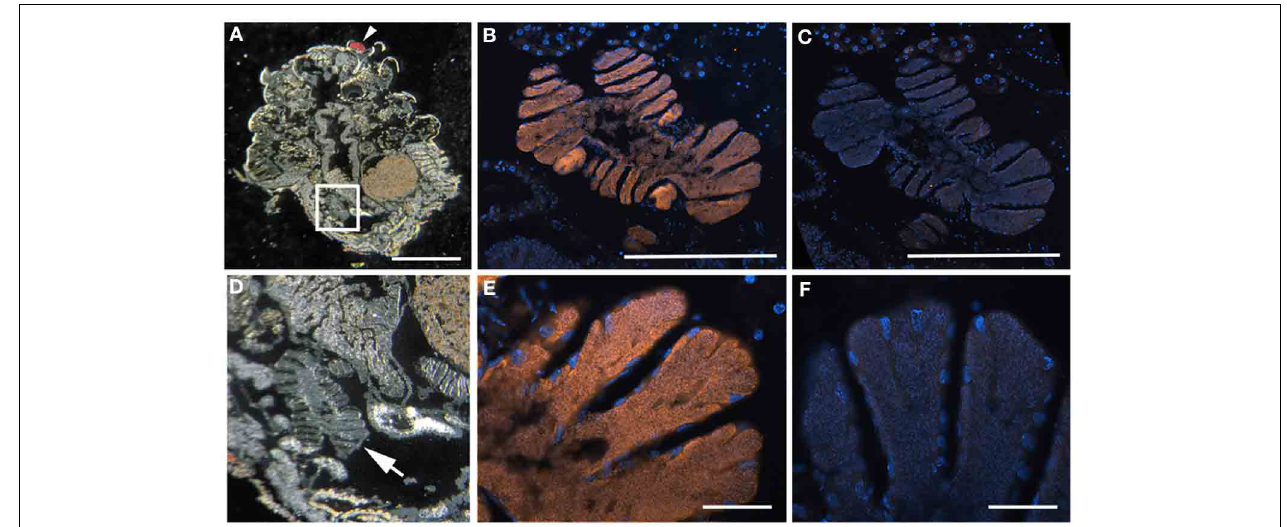
FIGURE 9 | Sibariaenglemani nymph FISHmicroscopy.(A) Lightimagesof section through an entire S. englemani nymph, embedded in, and then removed from, Steedman’s wax prior to hybridization. The anterior of the specimen (eye) is denoted by the arrowhead. The box denotes the region shown in (B,C) . Scale, 1mm. (B) Fluorescence in situ hybridization (FISH) microscopy of the same region as shown in E, hybridized with the